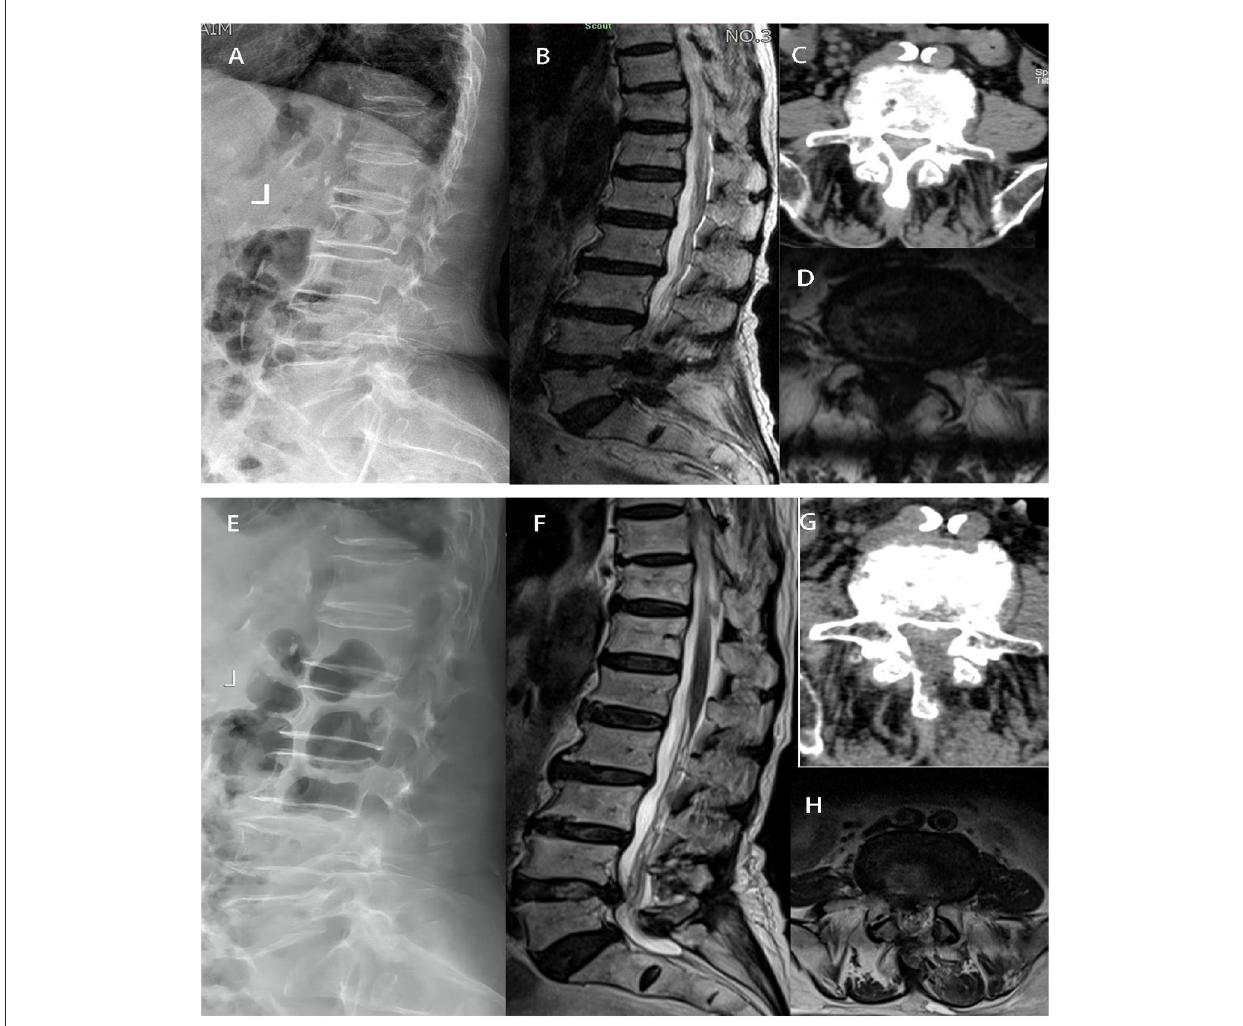
FIGURE2 In group UBE-ULBD, a 88-year-old woman suffered from low back pain accompanied with intermittent claudication more than 6 years. Preoperative Xray (A) , MRI (B, D) , and CT (C) examinations showed severe DLSS (Schizas Grade D) at L4/L5 level. The patient received UBE-ULBD and symptoms significantly relieved after the surgery. Postoperative X ray (E) , Post-operative CT/MRI indicated completed decompression was achieved at L4/L5 (F–H)